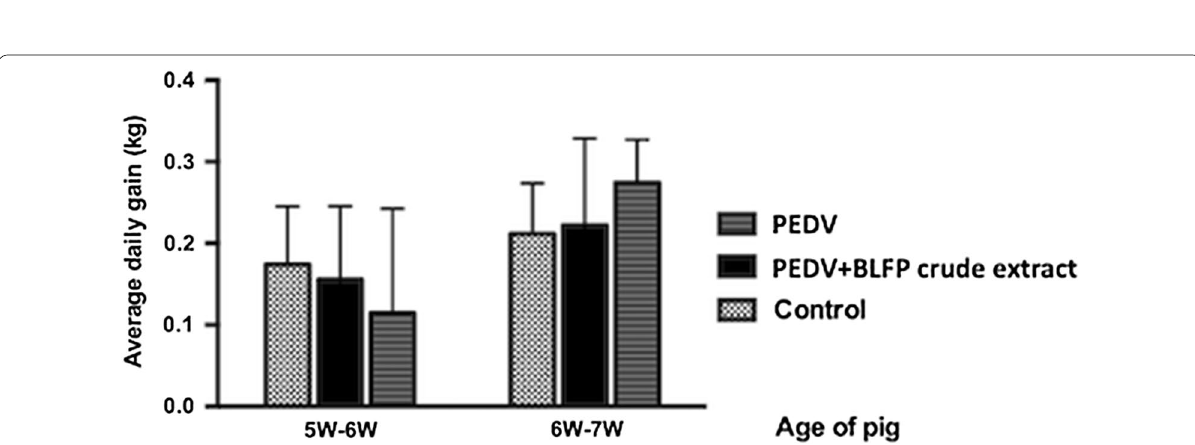
Fig. 4 Average daily gain of pigs in each group. All pigs were weighed weekly in order to evaluate their growth performance with or without BLFP as feed additives. No statically significant difference in the average daily gain was noted among all groups each